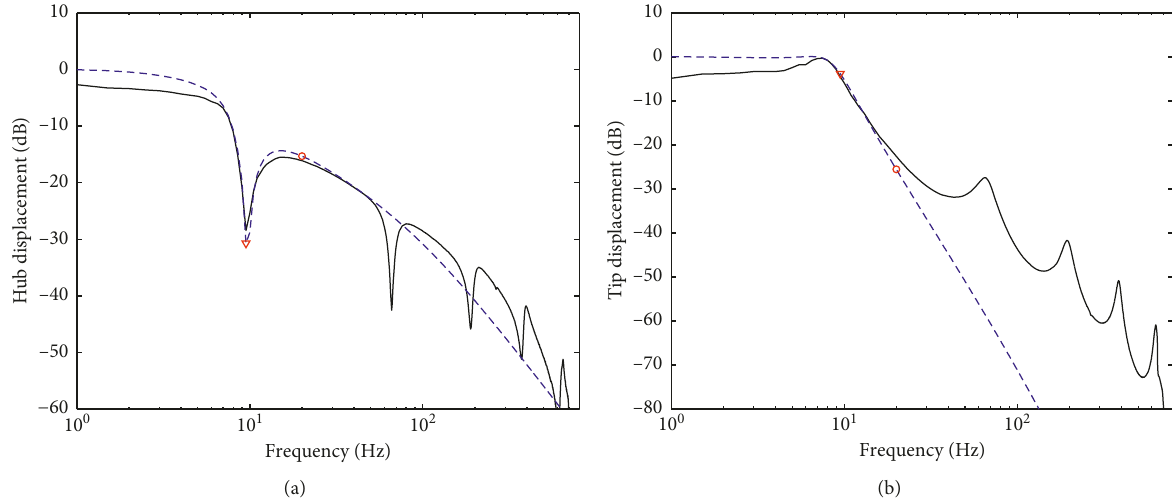
Figure 10: Measured (solid lines) responses of the manipulator system for η c two-body LES ( k 0): (a) the hub displacement T 01 and (b) the tip displacement T 02 . The symbols, “ uncoupled appendage and base natural frequencies, ω a and ω b , respectively. ≠ ≠